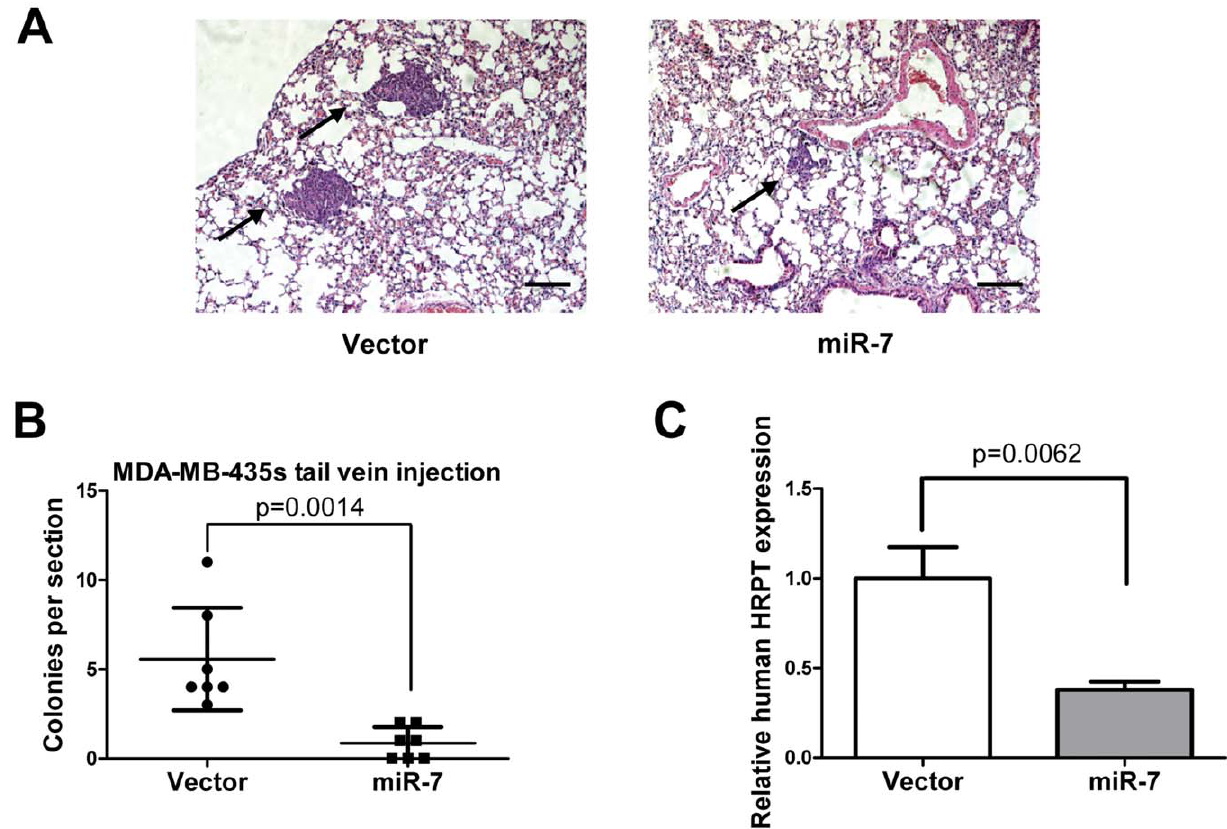
Figure 7. miR-7 inhibits breast cancer cell metastasis to mice lungs. (A) H&E stained sections of lungs isolated from mice that received tail vein injection of miR-7 or control infected MDA-MB-435s cells (scale bar: 100 m m). (B) Numbers of lung micrometastases per section in individual mice (each data point represents a different mouse; n=7 mice per group). (C) Expression of human HPRT mRNA relative to mouse 18S rRNA in the lungs of the tumor-bearing mice.